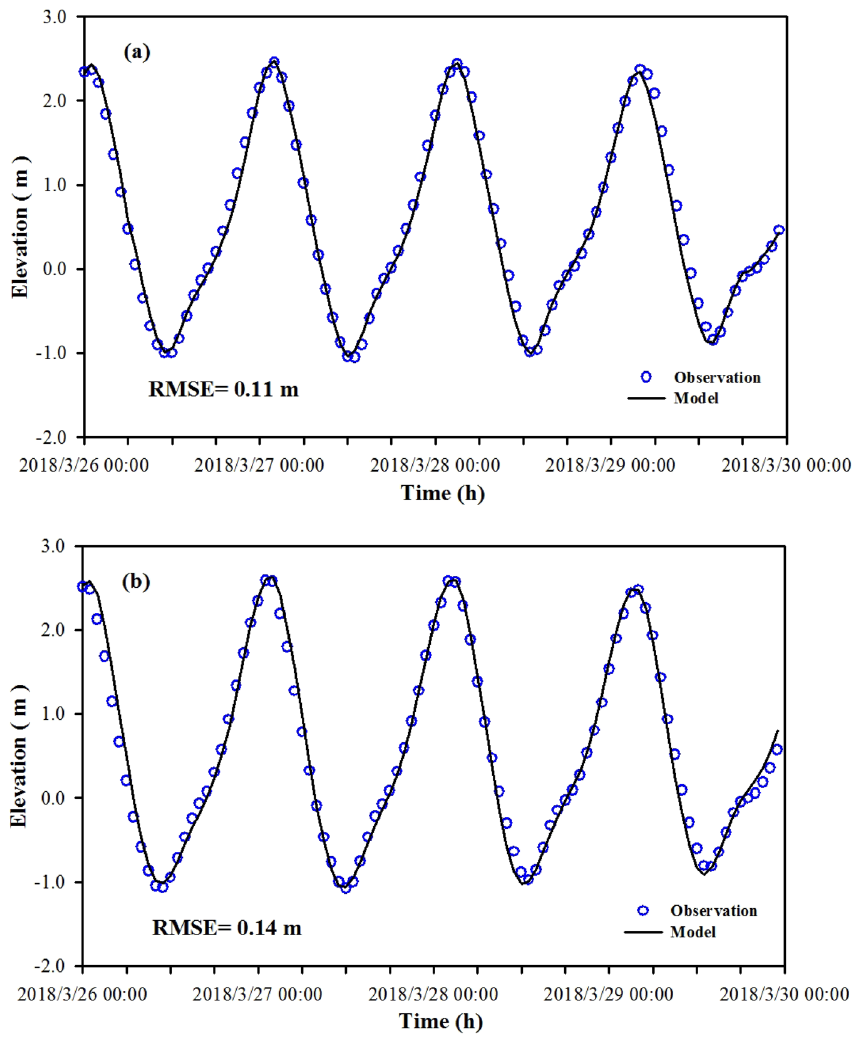
Figure 2. The variations of water elevation between observation and model with time ( (a) is for T1 station and (b) is for T3 station). These figures were prepared with SigmaPlot Version